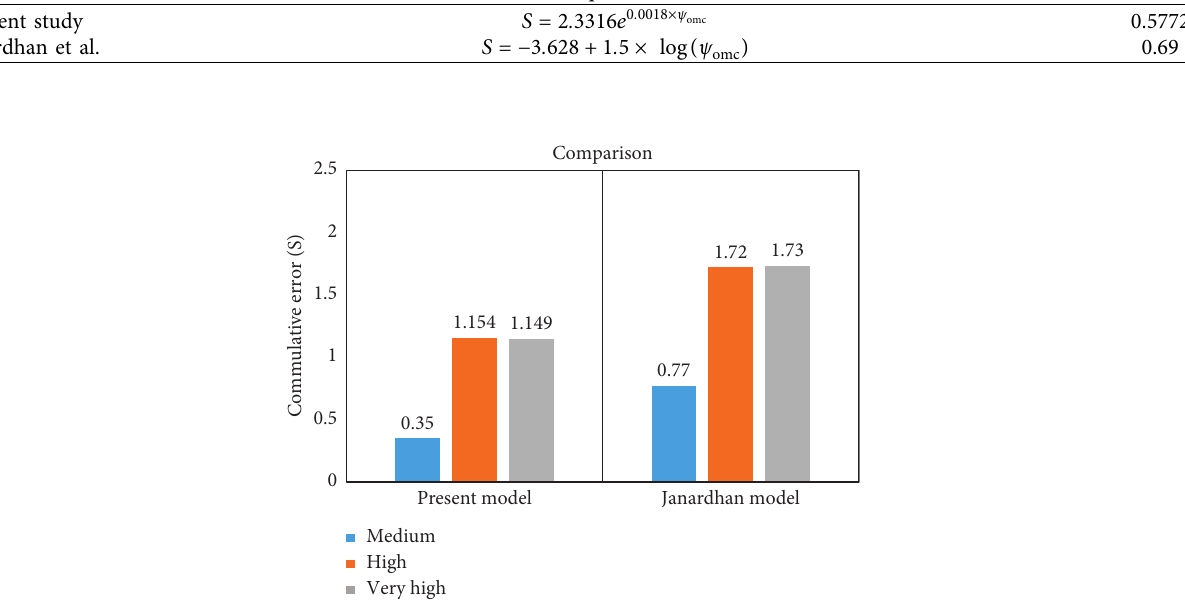
Figure 16: Comparison of cumulative errors in the current and previous models. Table 11: Demonstration of the cumulative errors that occurred for the three types of expansive